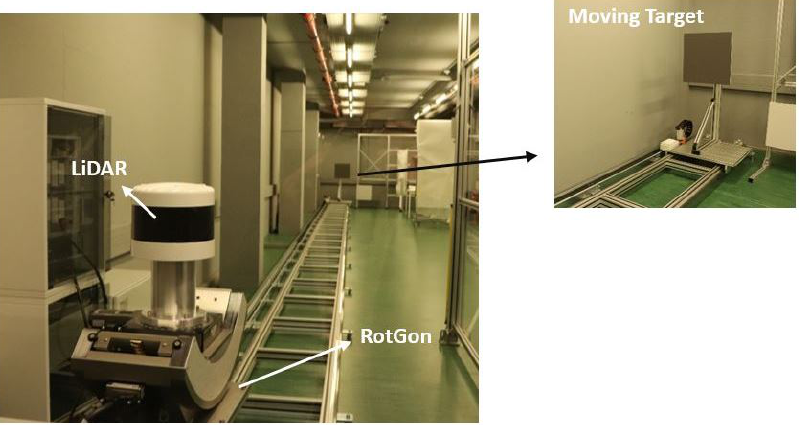
Figure 6. Evaluation and testing platform with the goniometric rotation system, LiDAR sensor, and the rail